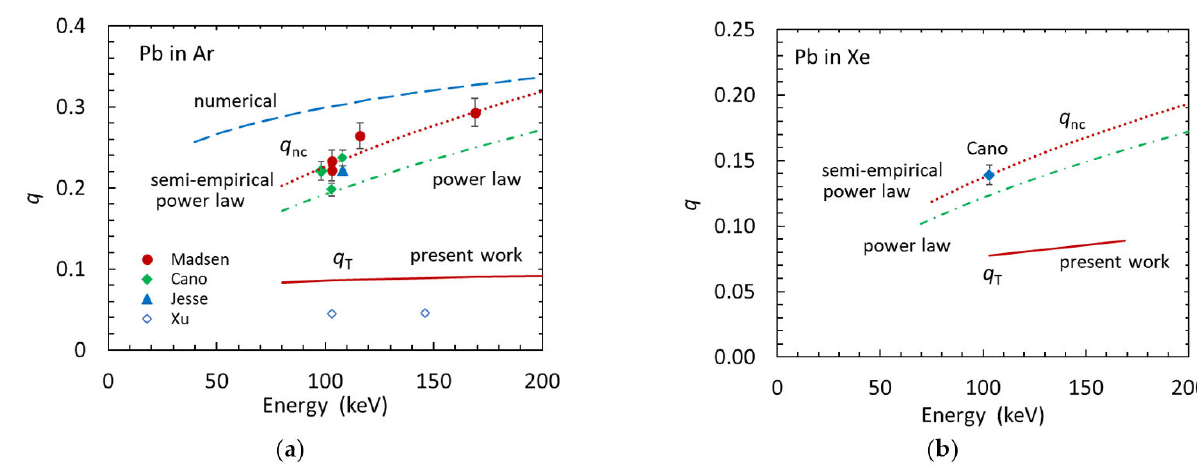
Figure 4. Quenching factors q T and q nc for heavy recoils in α -decay. ( a ) Quenching factors in liquid Ar. Calculations are for 208 Pb ions. Symbols are W α / W 206 Pb, 208 Tl and 208 Pb ions by Madsen ( • ) [27]. Points for 103 NR measurements in gas for keV 206 Pb recoil ions by Cano (closed diamond) [29] and Jesse and Sadauskis (triangle) [28] are shifted for clarity. Numerical results (dashed curve) and the power-law approximation (dot-dashed curve) for q nc by Lindhard et al. are shown [23]. The dotted curve shows q nc estimated by Ling and Knipp [30]. Measured q T values by Xu et al. [35] are shown with open diamonds (corrected for L γ 0 ) together with present calculation (solid curve). ( b ) Quenching factors in liquid Xe. W α / W NR measurements for 206 Pb in gas by Cano (closed diamond) [29]. Calculated values for q nc are the power-law approximation (dot-dashed curve) by Lindhard et al. and the present approximation (dotted curve). The present calculation for q T is shown by the solid